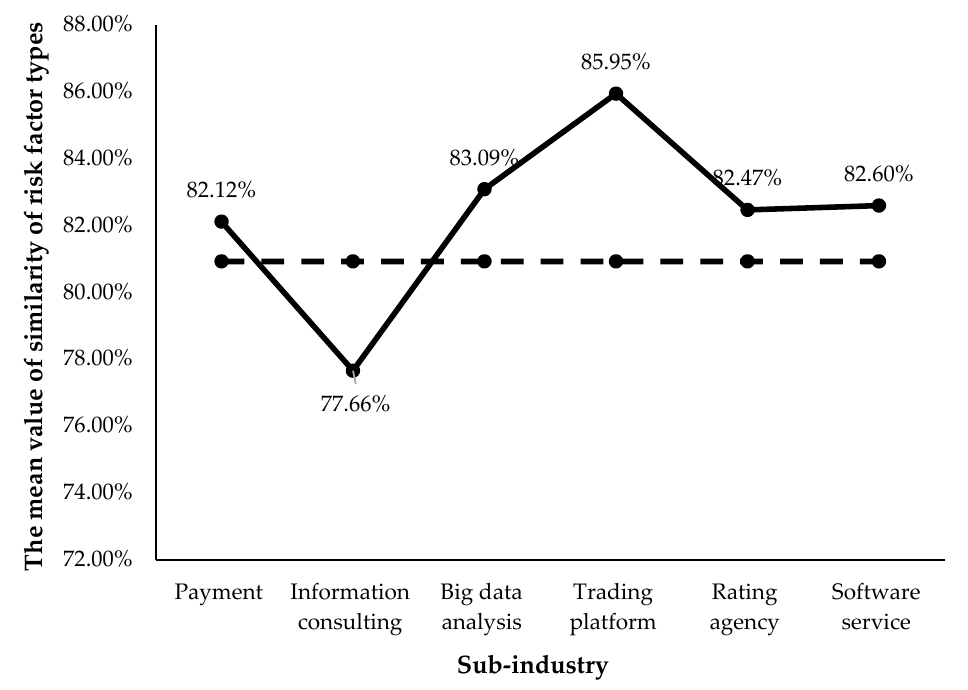
Figure 4. The mean value of similarity of risk factor types within different fintech subsectors .